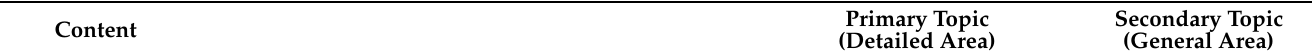
Table 2. Self-awareness for reflection (n = 310)